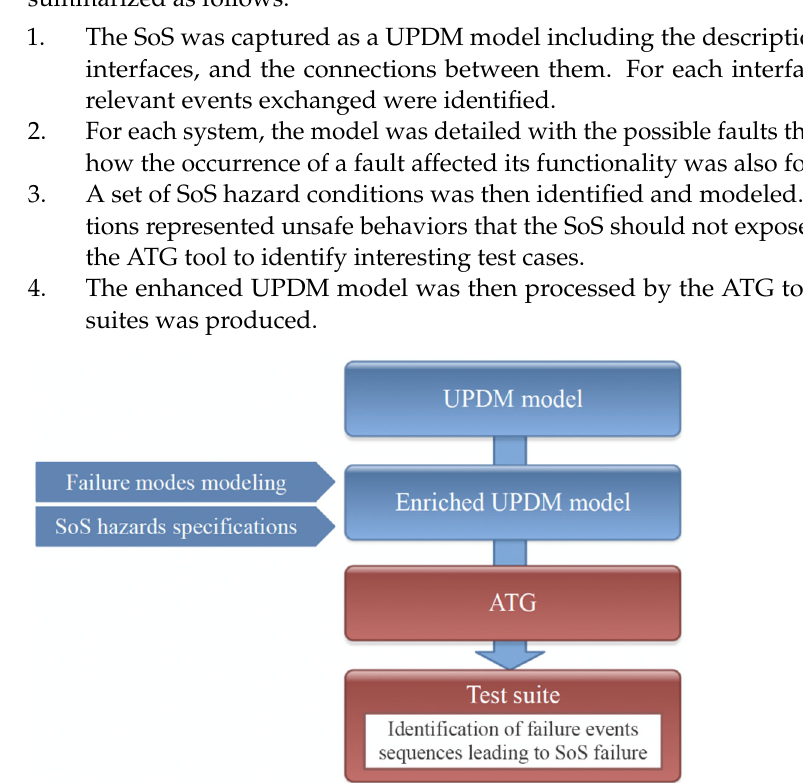
Figure 3. Fault injection ‐ based ATG abstraction level workflow for model ‐ based SoS engineering.